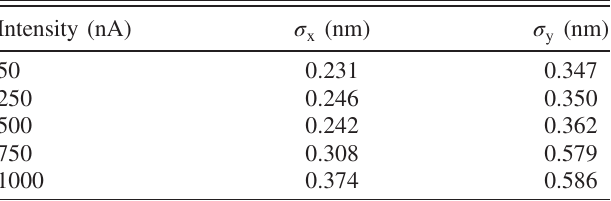
TABLE II. The full width FWHM of Gaussian fits of the cooled beam transverse profiles for various beam